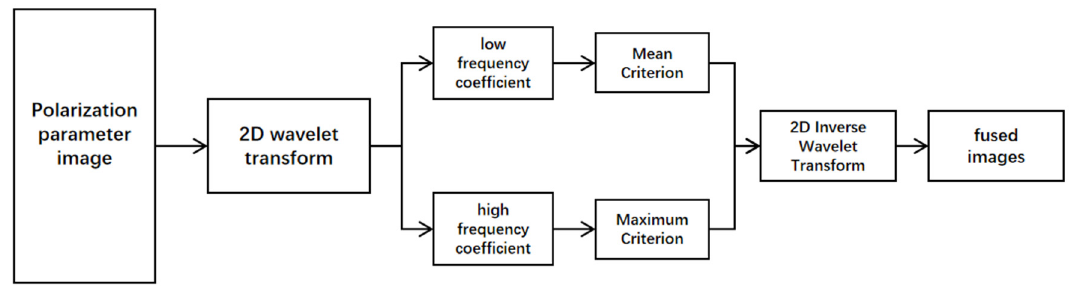
Figure 3. Image fusion process based on two-dimensional wavelet transform.